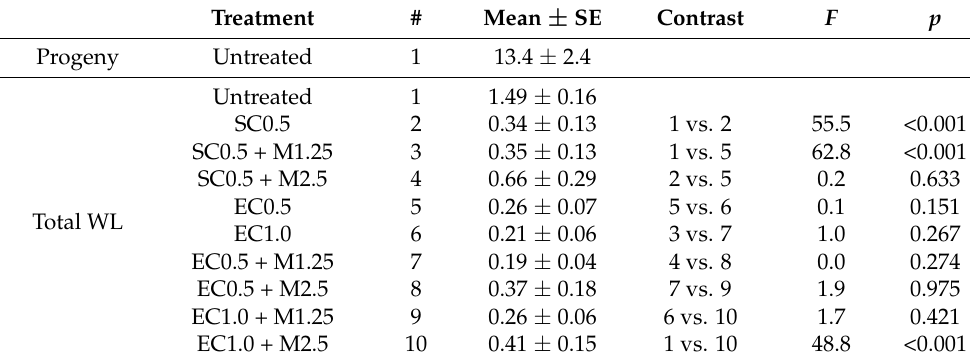
Table 4. Total weight loss (WL in %, means ± SE) from exposure of 10 mixed-sex parental adult T. castaneum on corn treated with the insecticide combinations Table 1. F and p values given for selected orthogonal contrasts. Progeny production in untreated wheat was 13.4 ± 2.4 and frass weight was 0.41 ± 0.04 g. No progeny production or frass in the treatments.